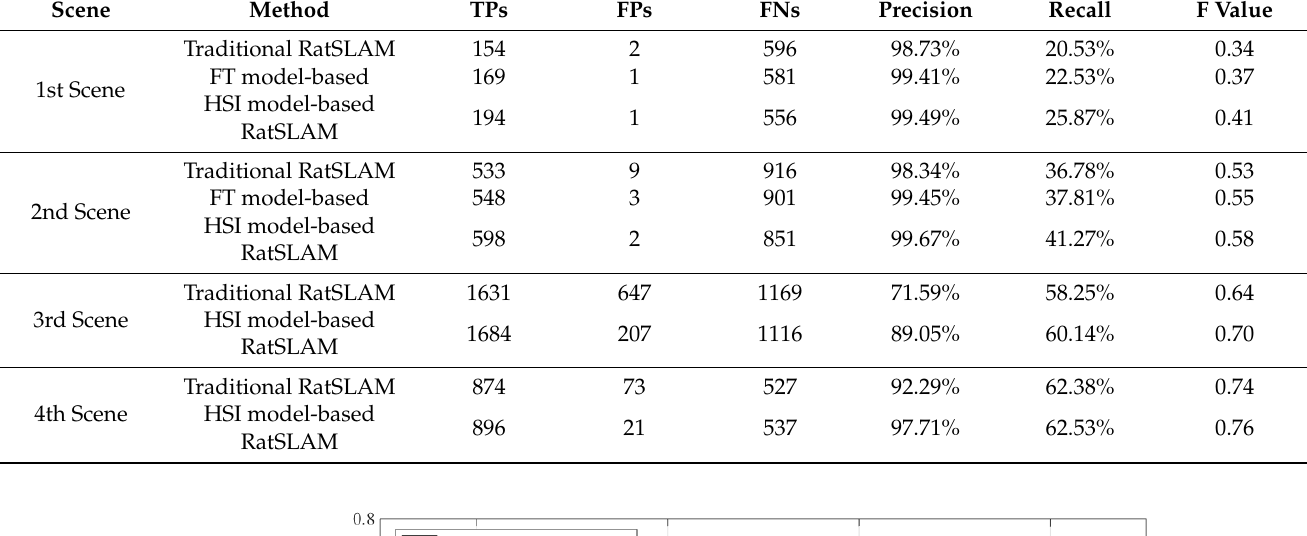
Table 4. Statistical table of accuracy, recall rate, and F-value.